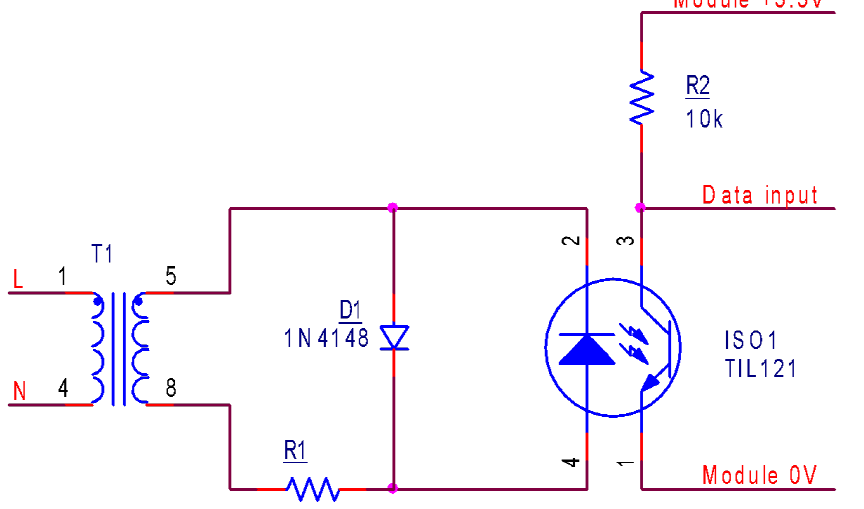
Figure 15. Baseline frequency measurement circuit as developed by D. Mohapatra in [6].